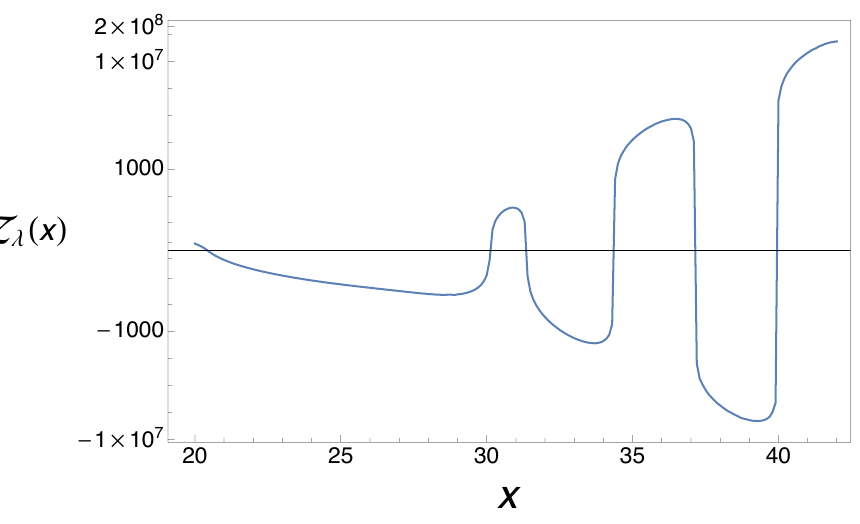
Figure 10. We plot Z λ ( x ) against x at T = 0 . 3 and λ = − 2 in the symmetric logarithmic scale, i.e., [ sgn Z ( x )] log [ |Z ( x ) | + 1] . One can see that the valleys’ depths deepening towards the right makes λ λ e −Z λ ( x ) [and therefore D ( x ) and F q,λ ( T ) ] unbounded in the large x limit. Yet, it is not